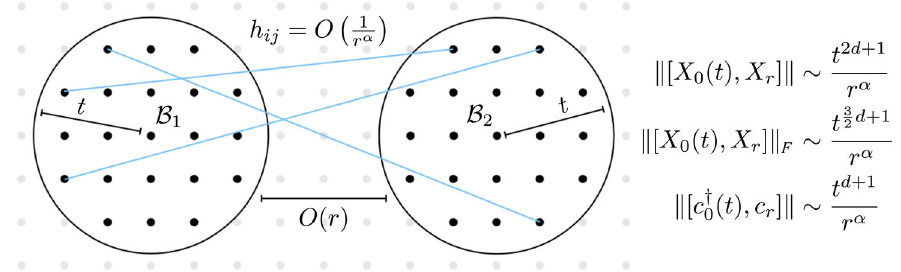
FIG. 2. The norm of the interaction between two balls B 1 of size t , separated by a distance r , determines the shape of the light cone. ; 2 The critical values of α after which this norm becomes large differ depending on whether we use the operator or Frobenius norm and whether the system is interacting or